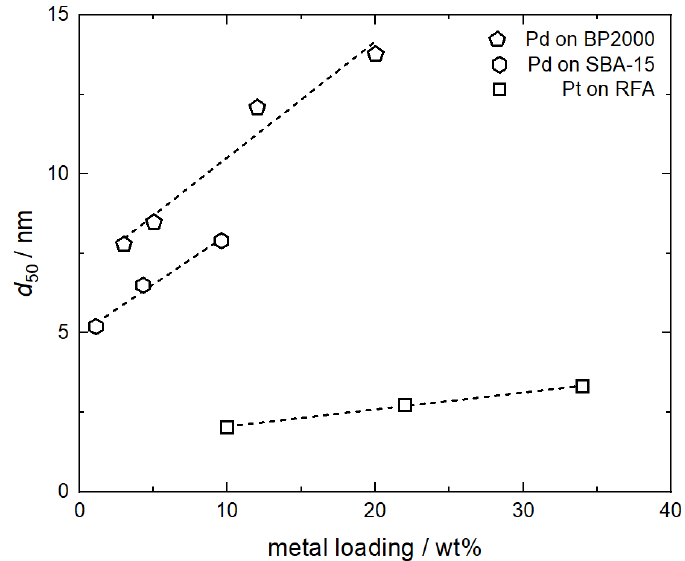
Figure 1. Influence of metal loading on mean particle size; experimental data taken from [8–10]. The dashed lines are a guide for the eye.